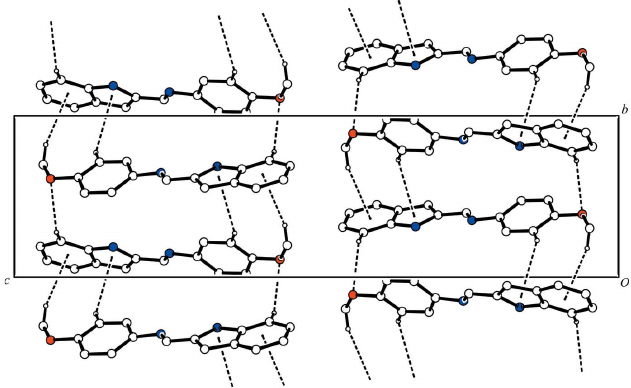
Figure 3 Part of the crystal structure of the title compound showing the formation of ribbons along the b -axis direction. The C—H (cid:2)(cid:2)(cid:2) (cid:2) interactions are shown as dashed lines. H atoms not involved in these interactions are omitted for clarity.